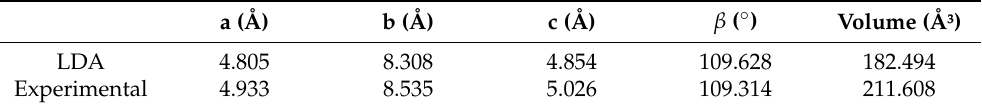
Table 1. Optimized structural parameters of the Li 2 MnO 3 crystal determined by DFT calculations.